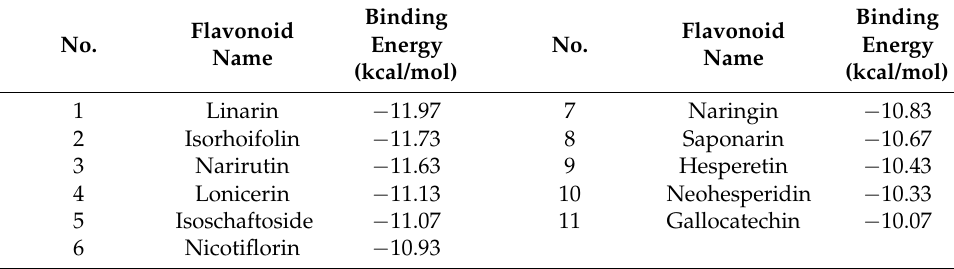
Table 5. Molecular docking results of flavonoids at PLpro.